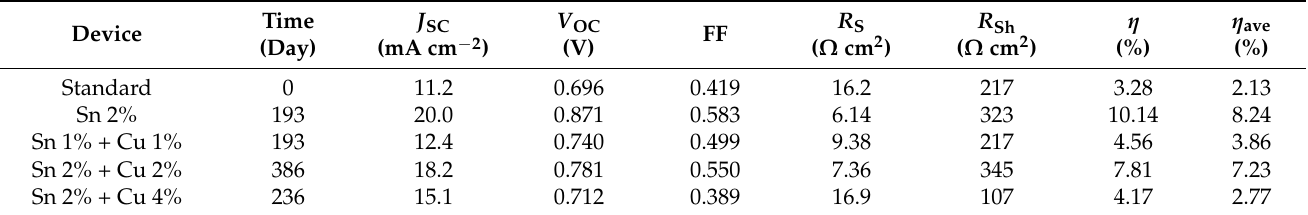
Table 3. Photovoltaic parameters of the perovskite solar cells with the best photoconversion efficiencies.